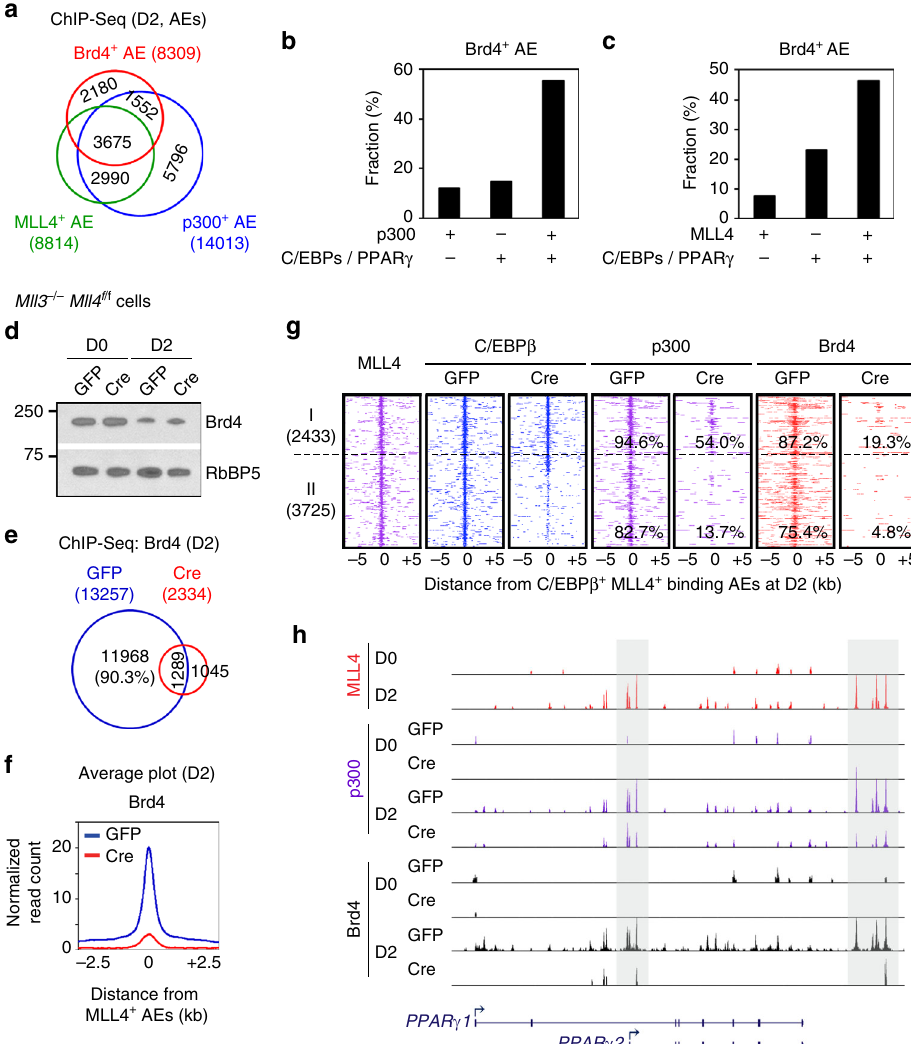
Fig. 6 LDTFs, MLL3/MLL4, and p300 coordinate to recruit Brd4 to active enhancers. a Venn diagram of co-localization of Brd4, MLL4, and p300 on active enhancers (AEs) at D2 of adipogenesis. b , c Brd4 binding is highly enriched on AEs that are bound by both LDTFs (C/EBPs or PPAR γ ) and p300 b or MLL4 c during adipogenesis. d – h MLL3/MLL4 are required for Brd4 binding on AEs during adipogenesis. Immortalized Mll3 − / − Mll4 f/f preadipocytes were infected with adenoviral GFP or Cre as described previously 19 , followed by adipogenesis assay. Cells were collected before (D0) and during (D2) adipogenesis for ChIP-Seq of Brd4. d Deletion of MLL3/MLL4 does not affect Brd4 protein levels. e Venn diagram representing Brd4 binding regions in GFP- and Cre-infected Mll3 − / − Mll4 f/f cells at D2 of adipogenesis. f Average pro fi le of Brd4 binding on MLL4 + AEs at D2. g Heat maps around C/EBP β + MLL4 + AEs at D2. AEs were classi fi ed into two groups: unchanged (group I) and decreased (group II) C/EBP β binding in Mll3/Mll4 double KO cells. h Genome browser view of p300 and Brd4 binding on Pparg locus in GFP- and Cre-infected Mll3 − / − Mll4 f/f